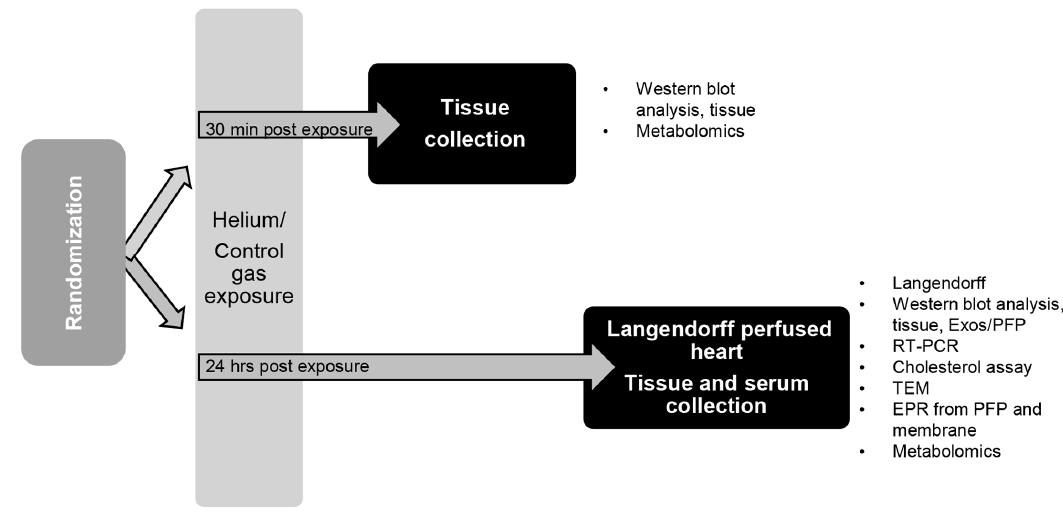
Figure 8. Experimental protocol overview of organ and blood collection. C57BL/6J mice were randomized into two different groups. Subsequently, mice inhaled either 70% He or 30% oxygen for 30 min in a Plexiglas chamber. Thirty minutes or 24 h post exposure, blood was drawn and hearts were excised for further analysis. PFP: platelet free plasma, PE: post exposure.